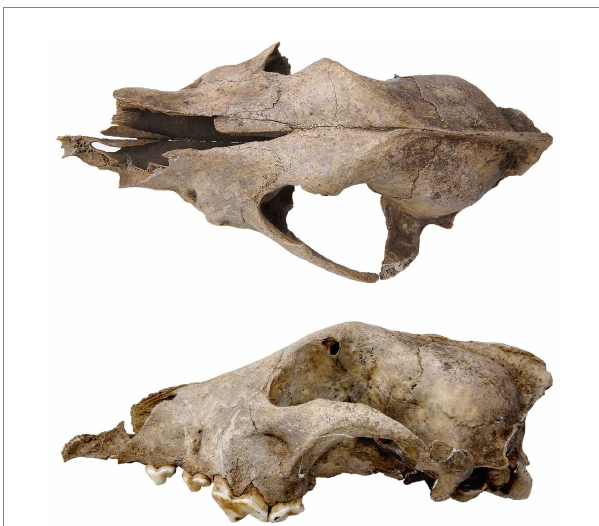
FIGURE 6 Dorsal (top) and lateral (bottom) view of the skull of the Paleolithic dog from Goyet cave, Belgium (RBINS; image credit: RBINS). Total skull length: 227